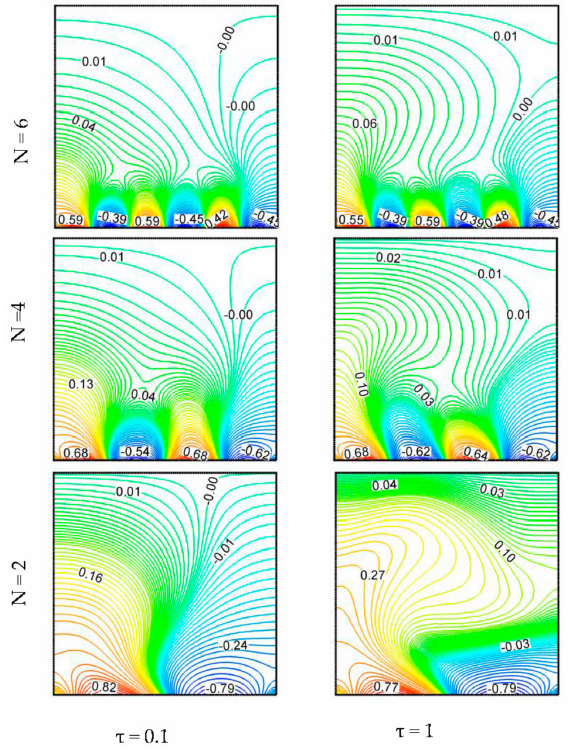
Figure 14. Influence of the even values of N on isotherms for the selected values of τ with Gr = 10 7